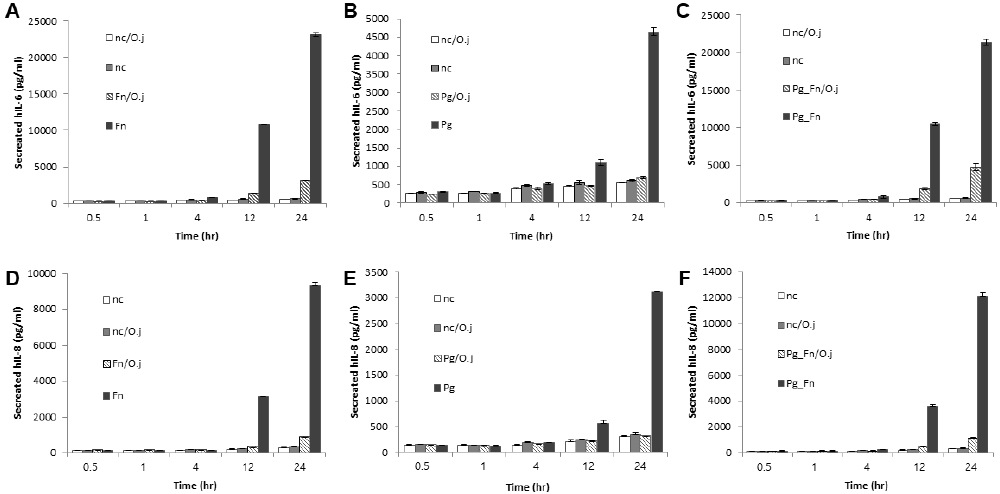
Figure 3. The inhibitory effect of the OJE on pro-inflammatory cytokine expression in PDLFs infected with oral bacteria for the indicated times. ( A – C ), IL-6; ( D – F ), IL-8. Human PDLFs were pre-treated with 100 µg/mL OJE prior to bacterial infection (M.O.I = 100). The PDLFs were infected with F. nucleatum ( A , D ), P. gingivalis (B,E), or a mixture of F. nucleatum and P. gingivalis ( C , F ). The values are the mean ± standard deviation of triplicate assays. F. nucleatum : Fn; P. gingivalis : Pg; F. nucleatum and P. gingivalis : Fn_Pg.